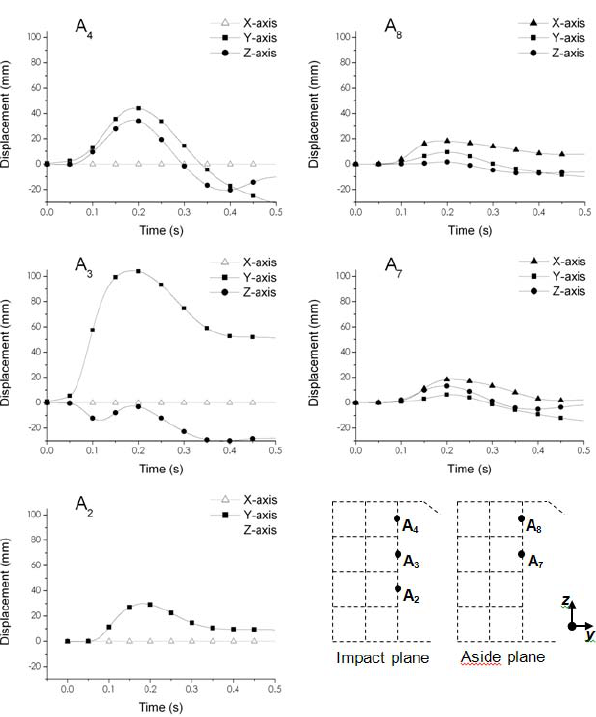
Figure 10. Displacement of the five sensors placed at the kernel– levee interface: A 2 , A 3 , and A 4 in the impact plane, A 7 and A 8 in the distant plane. Open symbol curves display assumed